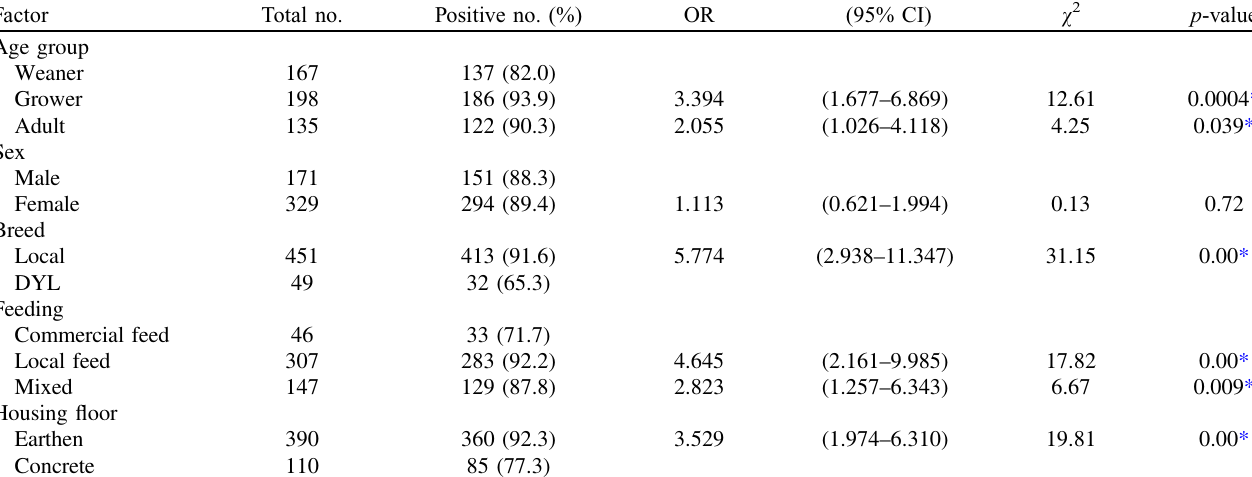
Table 2. Factors associated with coccidian infection in pigs in Nay Pyi